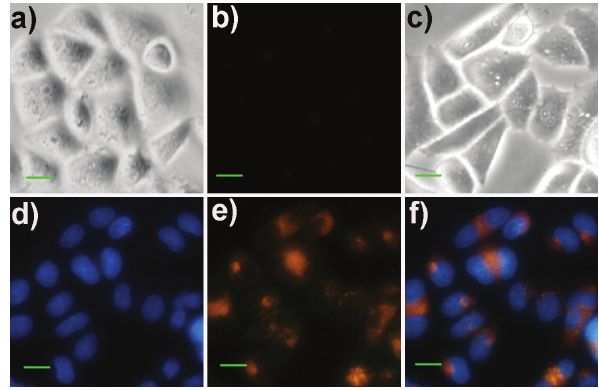
Figure 8 : Bright-field and fluorescence images of HeLa cells. (a) Brightfield image of the cells treated with sensor Rh6G-1 (10 μM) for 30 min; (b) Fluorescence image of panel (a) from the red channel; (c) Bright-field image of the cells pre-treated with sensor Rh6G-1 (10 μM) and Hoechst 33258 (4.5 μM) for 30 min, and then incubated with Fe 3+ (10 equiv.) for 30 min; (d) Fluorescence image of panel (c) from the blue channel; (e) Fluorescence image of panel (c) from the green/red channel; (f) Overlay of panels (d) and (e). Scale bar: 30